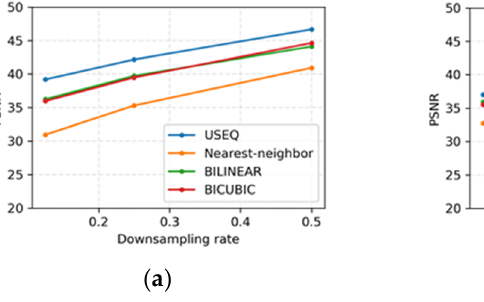
Figure 9. Average PSNR for different interpolation methods under different downsampling rates. ( a ) PSNR of JSRT dataset. ( b ) PSNR of LIDC-IDRI dataset. ( c ) PSNR of ANH dataset.